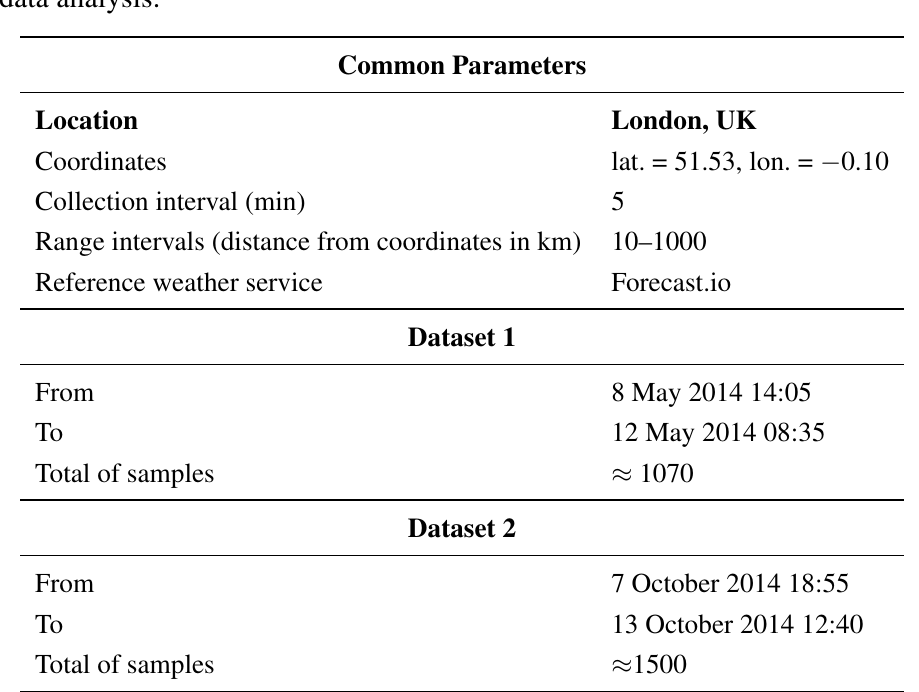
Table 1. Parameters for gathering data. Samples were collected from the region near London, UK, at different moments. The common parameters describe the intervals used for the data